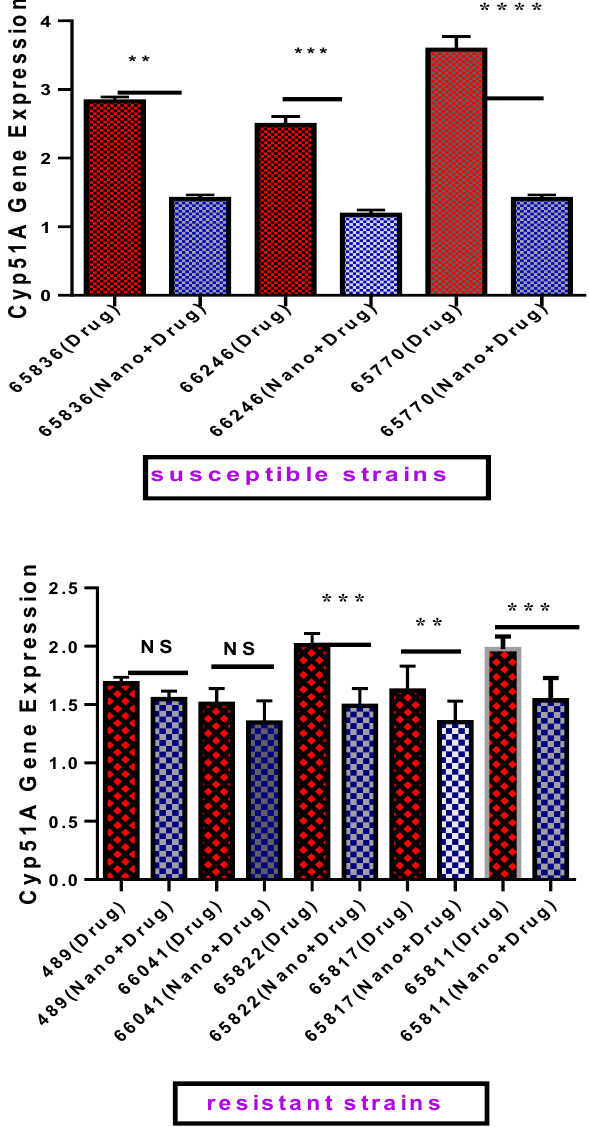
Fig. 3. Cyp51A gene expression in VCZ-resistant A.flavus isolates and VCZ-susceptible A.flavus